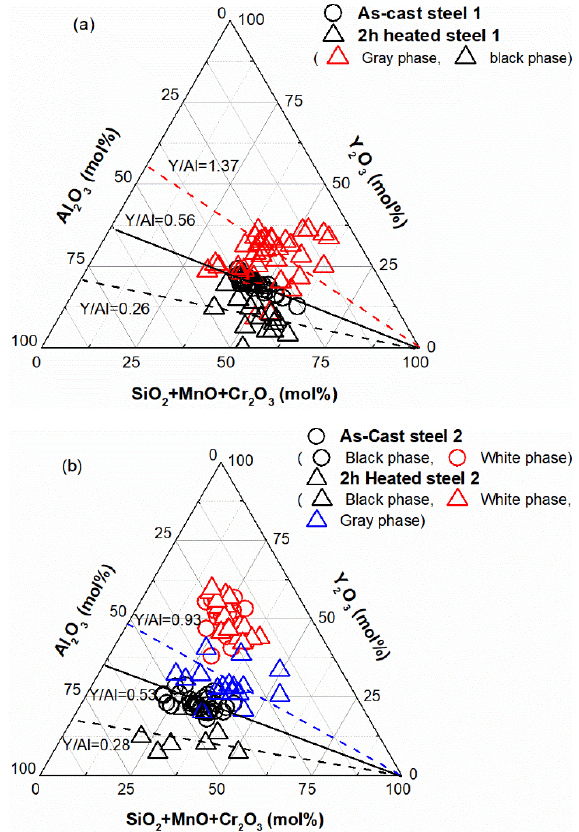
Figure 8. Composition distributions of oxide inclusions in steel #1 ( a ) and #2 ( b ) after heating for 2 h.